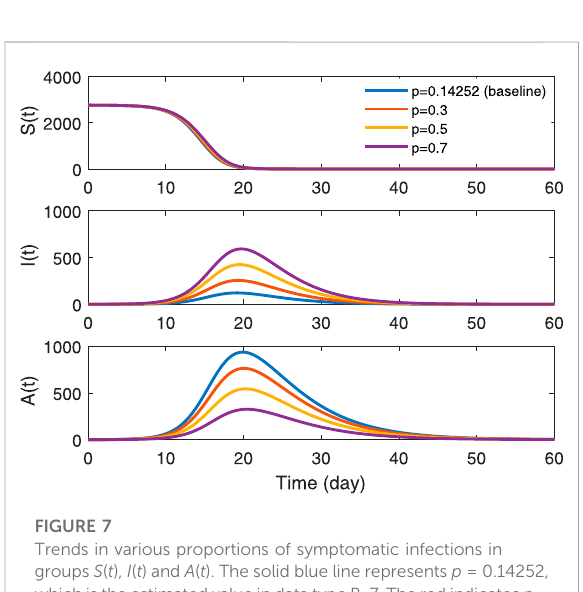
FIGURE 8 Trends in different isolation rates of symptomatic infections in groups S ( t ), I ( t ) and A ( t ). The solid blue line represents b = 1/4, which is the real value in data type B-7. The red indicates b = 1/2, the yellow is b = 1/1 and the purple denotes b =